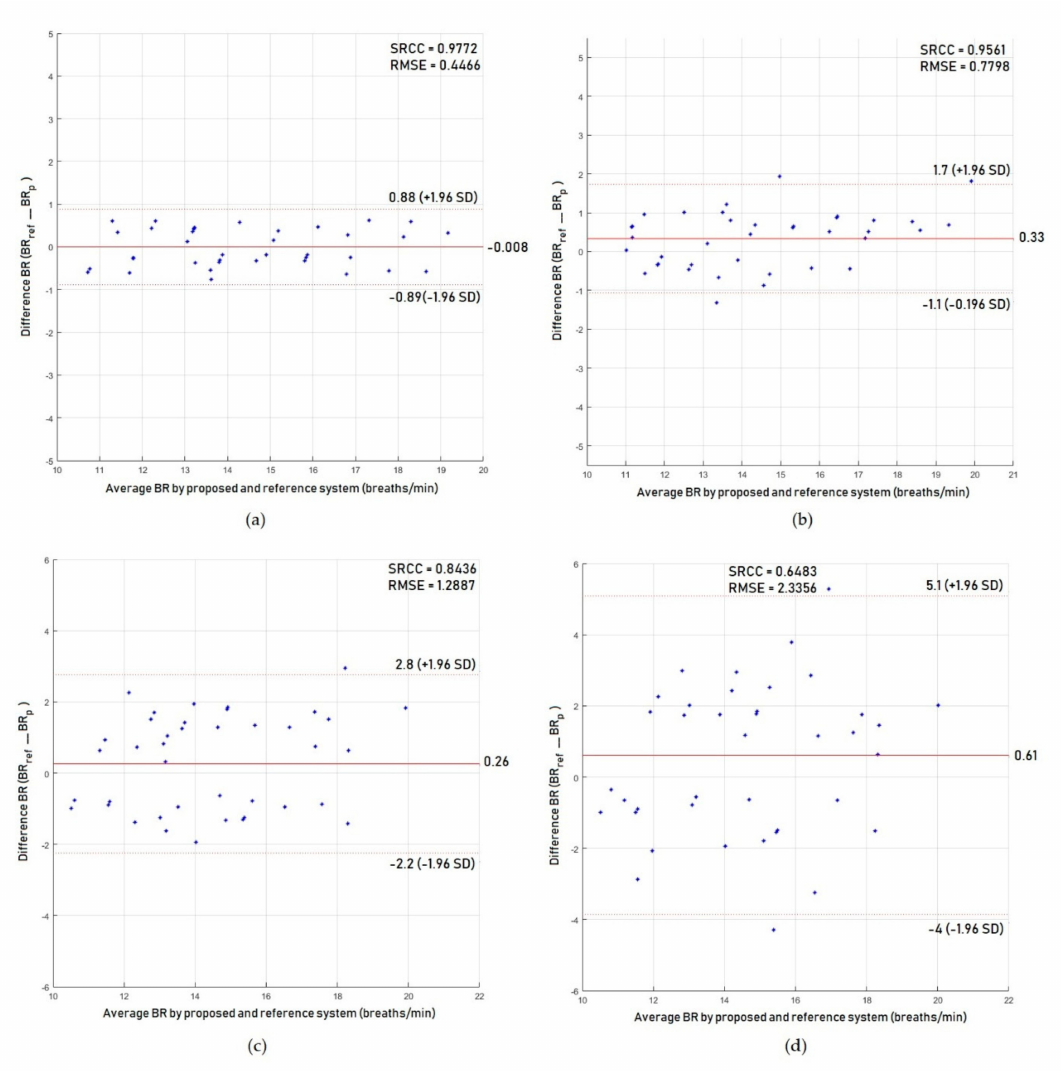
Figure 6. Bland-Altman plots comparing the readings obtained by the proposed monitoring system to